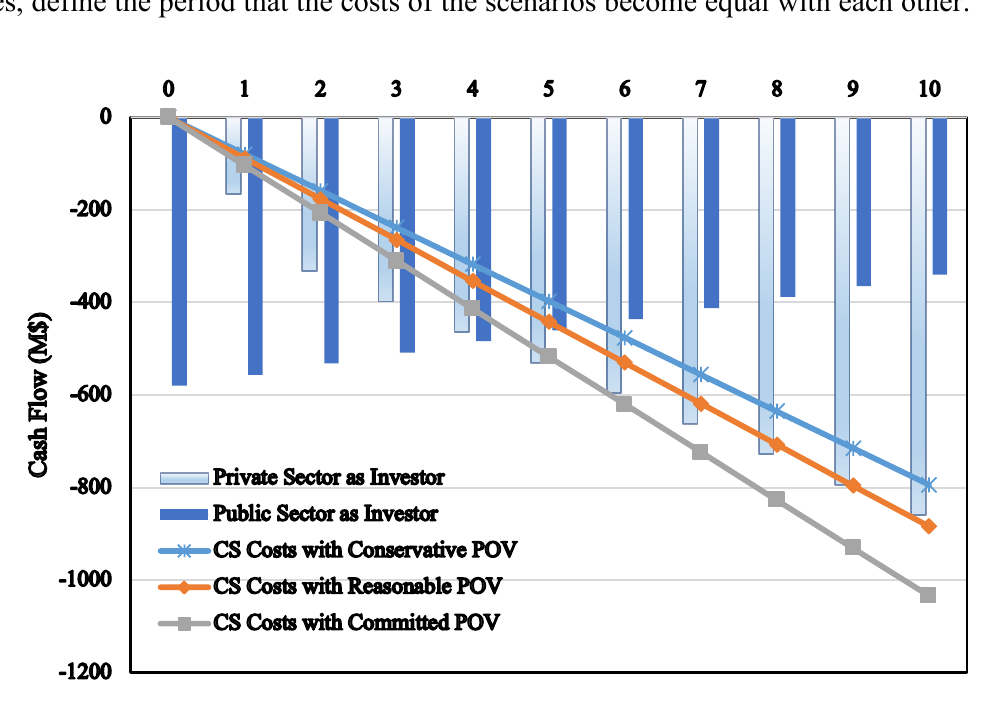
Figure 4 : Simple economic chart of the government costs in current condition and two scenarios Figure 4 implies that the cost-equal points between the 1 st scenario and the current circumstance is between 5 to 12 years. The cost equal points between the 2 nd scenario and current condition lies between 4 to 6 years. So it can be stated that although the 1 st scenario can decrease the government costs and is profitable for the private sector as well, the 2 nd scenario is the best possible option for the government, since it is associated with shorter cost-equal points, and turns the yearly costs to an annual income